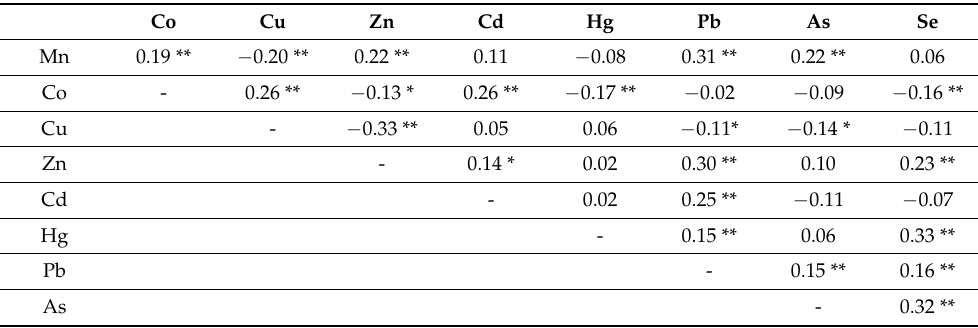
Table 2. Pearson’s correlation coefficients calculated between essential and non-essential elements in whole blood among all